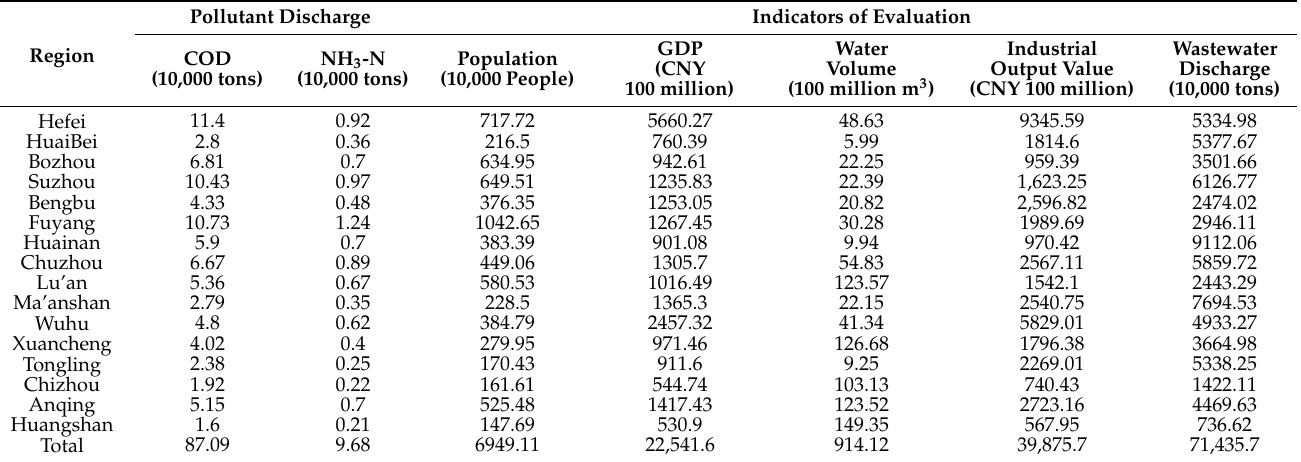
Table 1. Specific values of water pollution emissions and evaluation indicators of cities in Anhui Province in